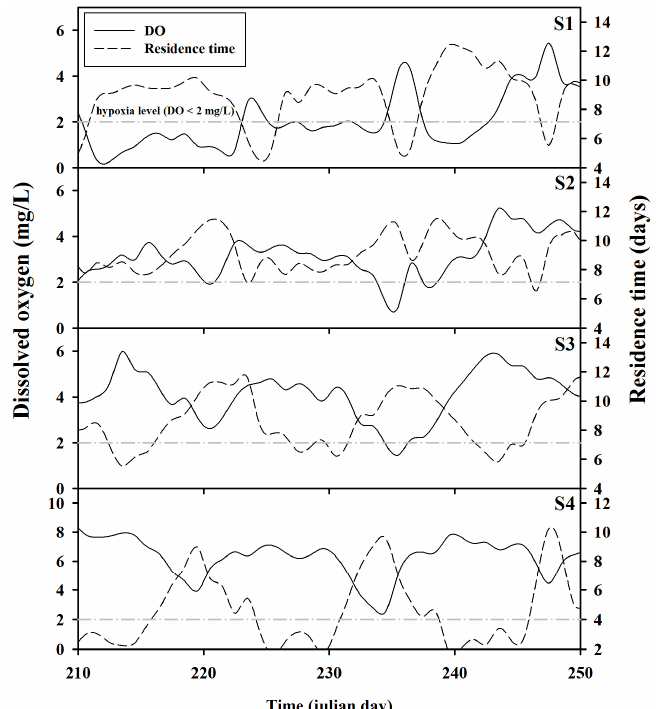
Figure 11. Temporal changes of DO concentration and residence time in the bottom layer at sites S1–S4 during the hypoxic period.